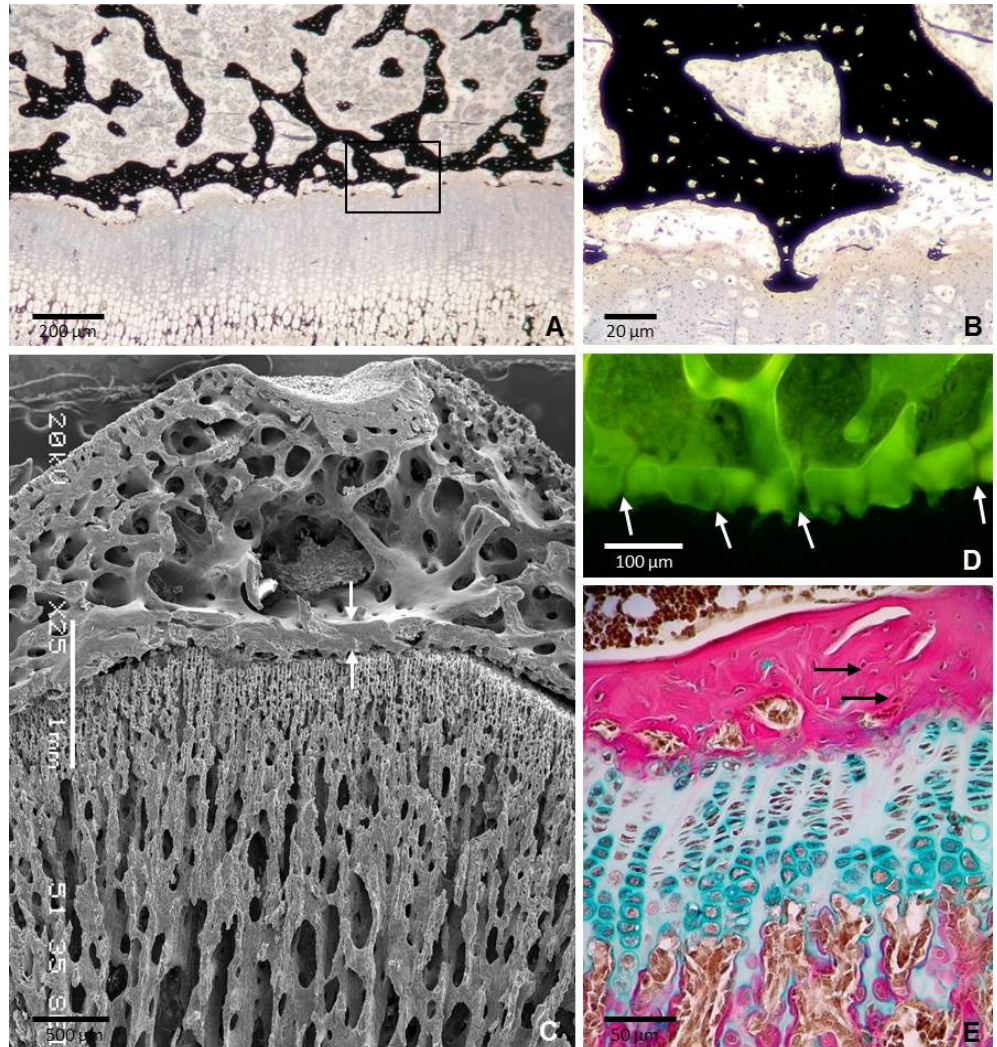
Figure 4. Sections of the tibial epiphysis of a 35 day-old rat. ( A ) Section stained with von Kossa showing that the epiphyseal bone plate and the underlying growth plate are bridged by a number of thin bony extensions. Boxed area is shown at a higher magnification in figure B. ( B ) Magnification of the boxed area in A showing a bone-cartilage contact. Note that osteocytes in the mineralized matrix are not aligned do not show a clear orientation. ( C ) SEM image showing that the epiphyseal plate is thicker than the cortical bone of the epiphysis (arrows). Note the continuity of the bone plate with the trabecular meshwork of the epiphysis. ( D ) Confocal microscopy image of a 3D projection reconstructed from z-stack images showing the foramina of the plate through which blood vessels passed (arrows). ( E ) Paraffin section stained with Alcian blue/acid fuchsin showing that collagen fibers are densely packed but are not arranged in a regular parallel pattern